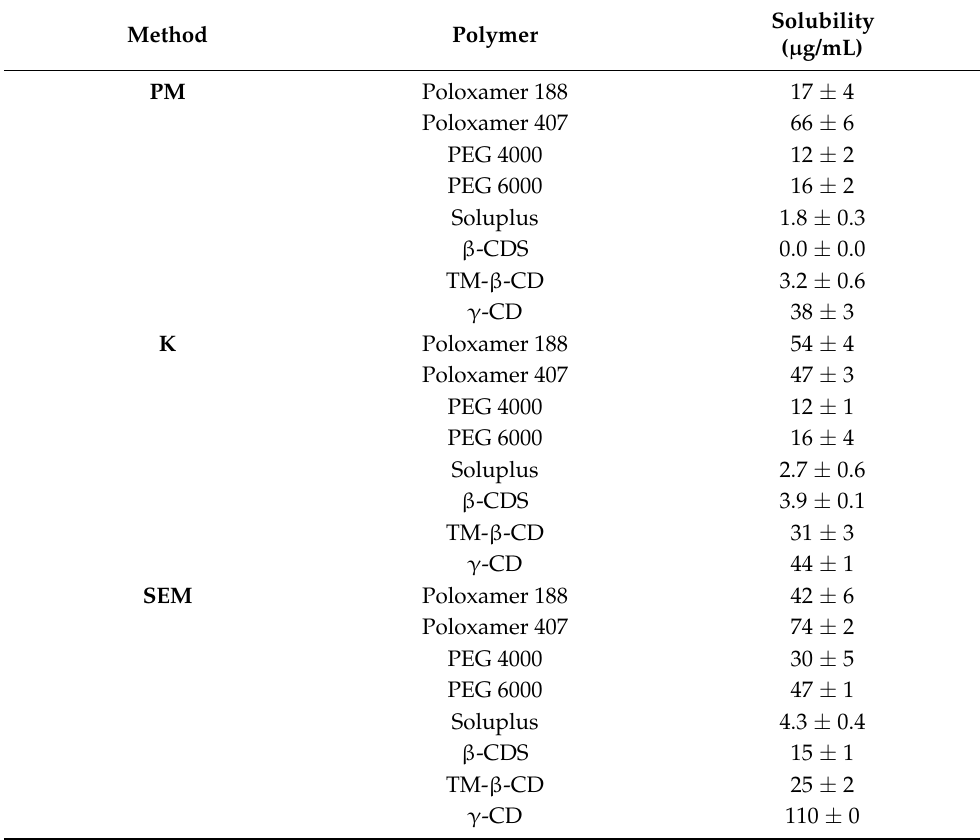
Table 1. Solubility of OA in hydrophilic polymers, using 1:1 drug-to-polymer weight ratio and differ- ent preparation methods (PM: physical mixture; K: kneading; SEM: solvent evaporation method).